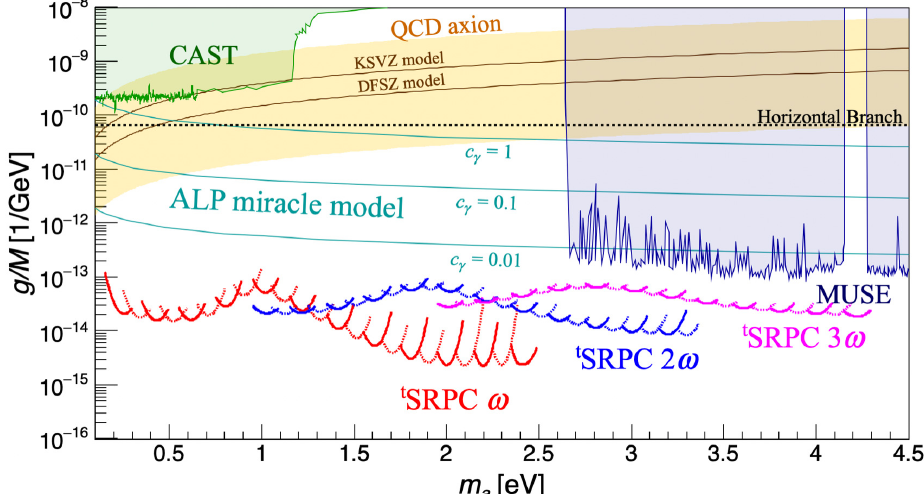
Figure 5. Expected sensitivities in the coupling–mass relation for the pseudoscalar field exchange at a 95% confidence level by a three-beam stimulated resonant photon collider ( t SRPC) with focused short-pulsed lasers based on the beam parameters in Table